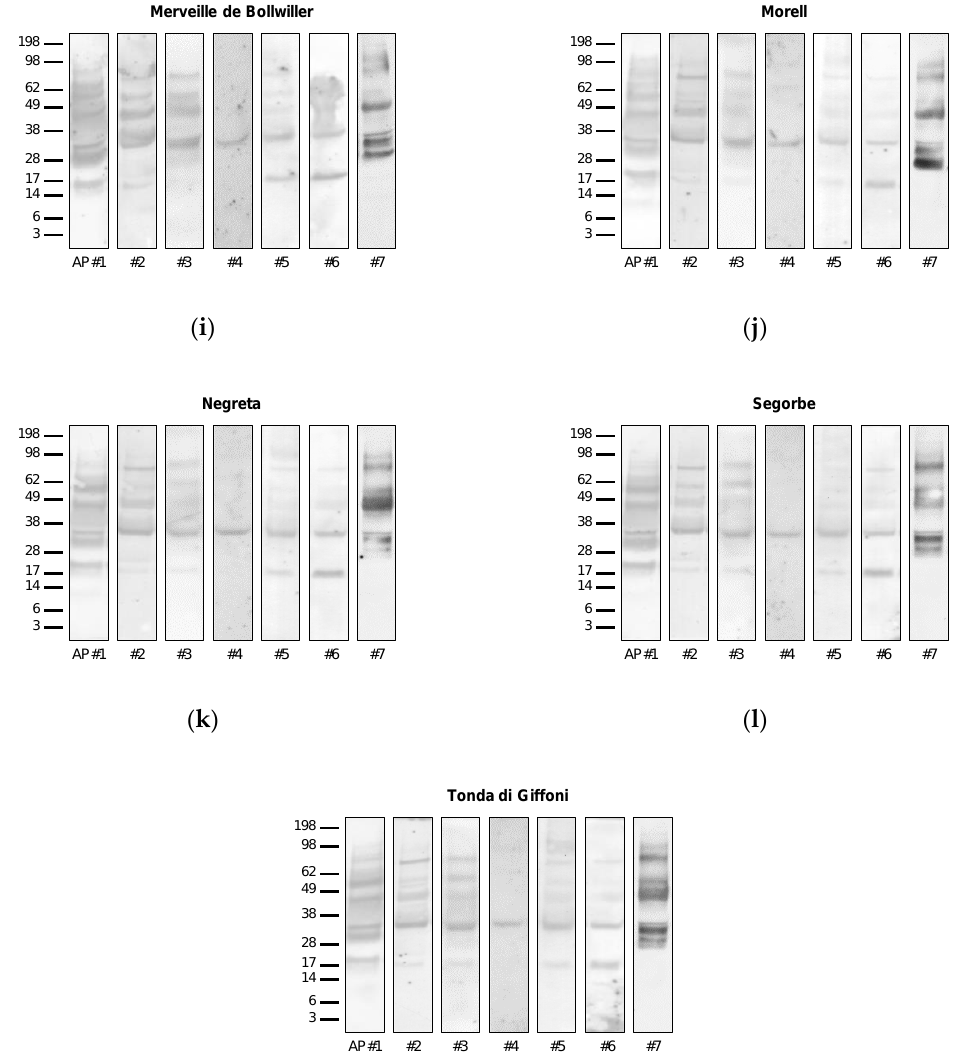
Figure 3. ( a – m ) Immunoblot of protein extracts from hazelnut varieties using individual sera from allergic patients. The secondary antibody was HRP-conjugated monoclonal anti-human IgE. Sizes (in kDa) of protein molecular weight markers (SeeBlue ™ Plus2 Pre-stained Protein Standard, Thermo Fisher Scientific, Waltham, MA, USA) are shown on the left.